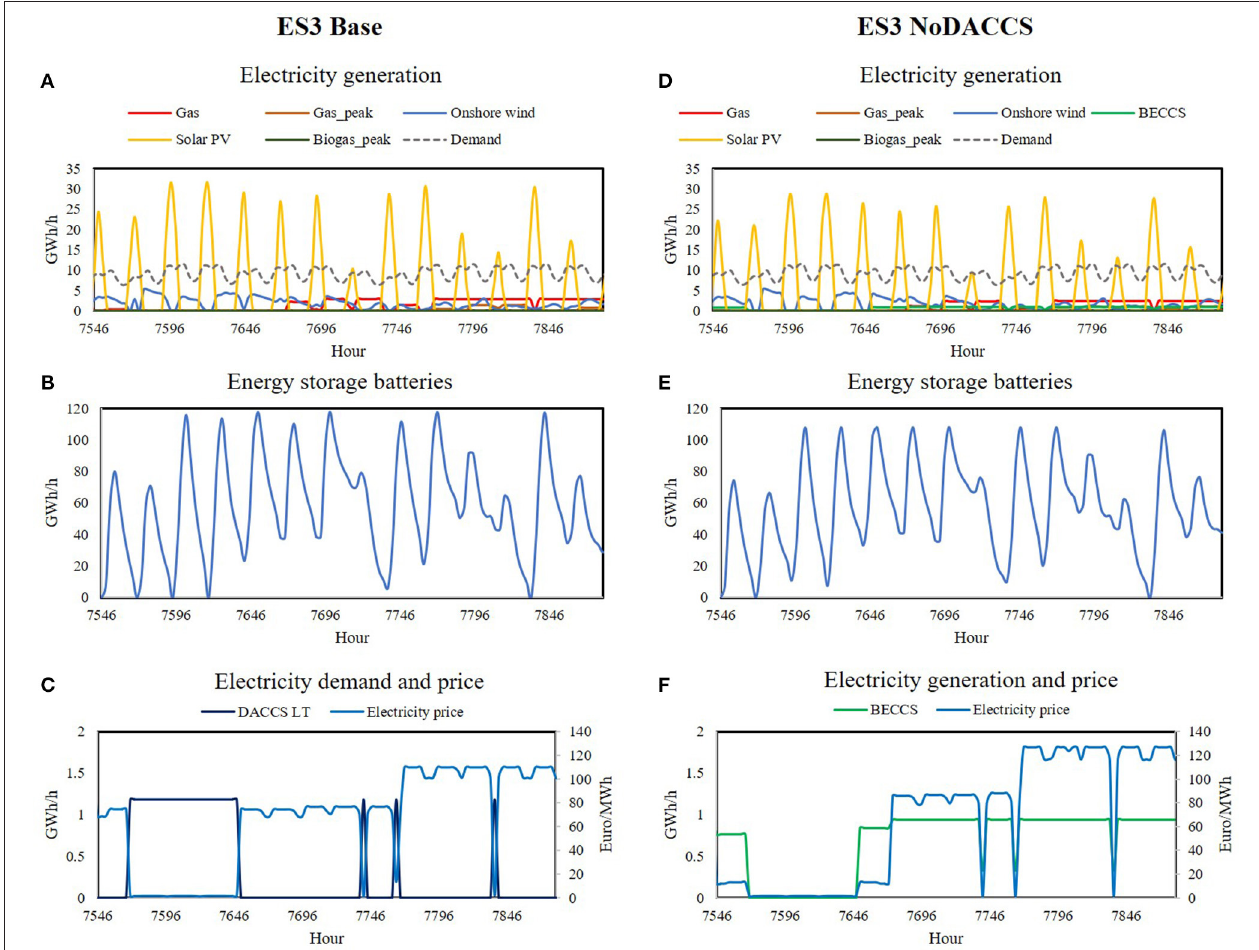
FIGURE 2 | (A) Electricity generation; (B) energy storage; and (C) electricity demand for DACCS and price for the Base case in region ES3 with in week 45 and 46 in year 2050. (D) Electricity generation; (E) energy storage; and (F) electricity generation by BECCS and price for the NoDACCS case in region ES3 with in week 45 and 46 in year